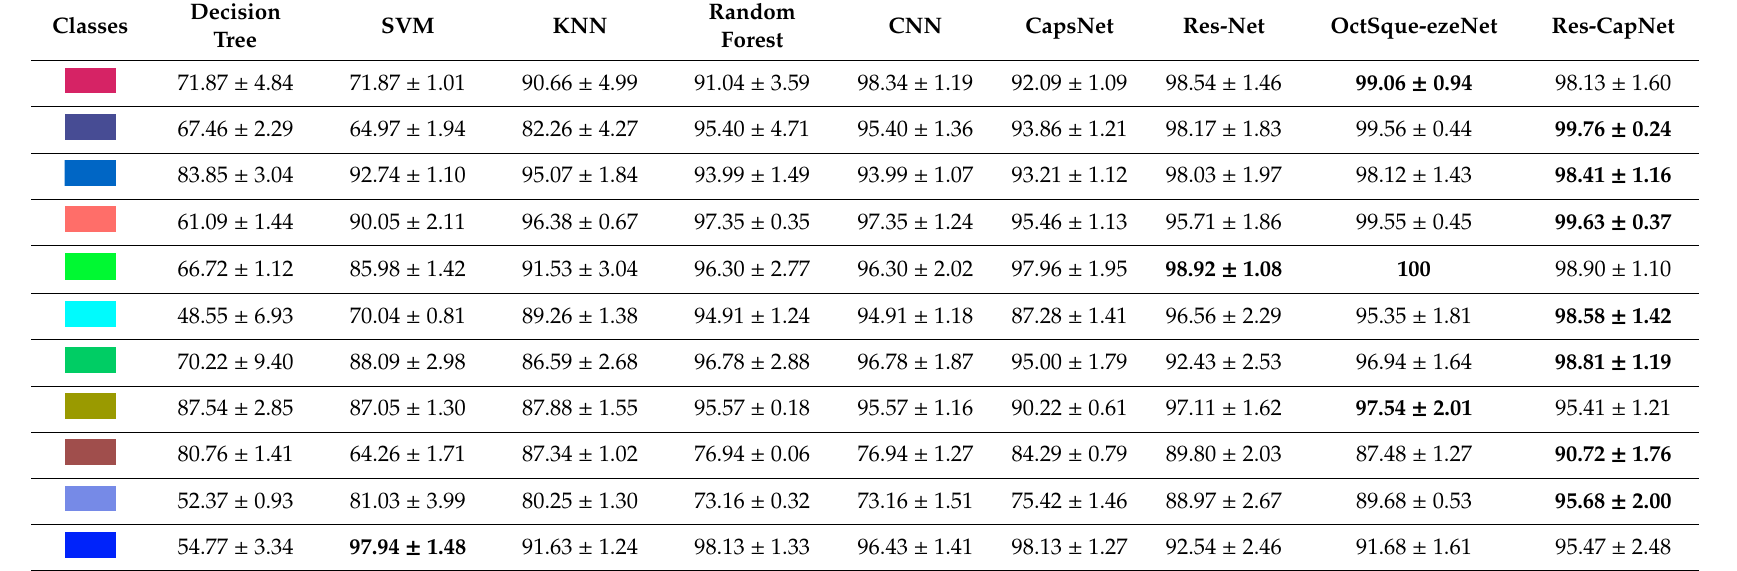
Table 7. Classification results of each class for 700 samples on Recology data set.